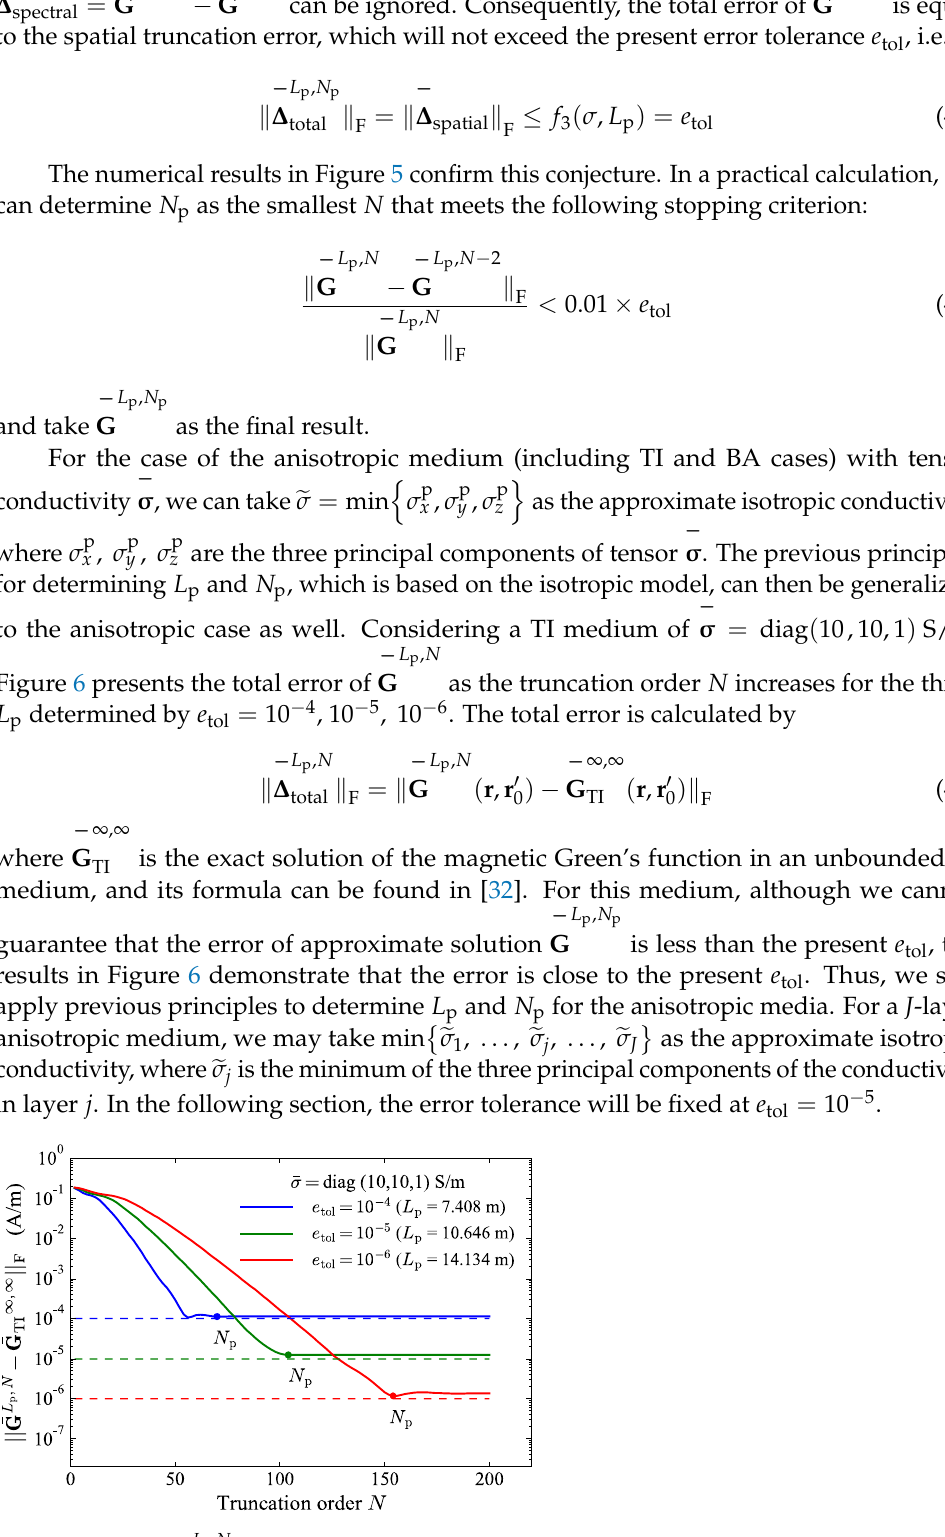
L when the me- p